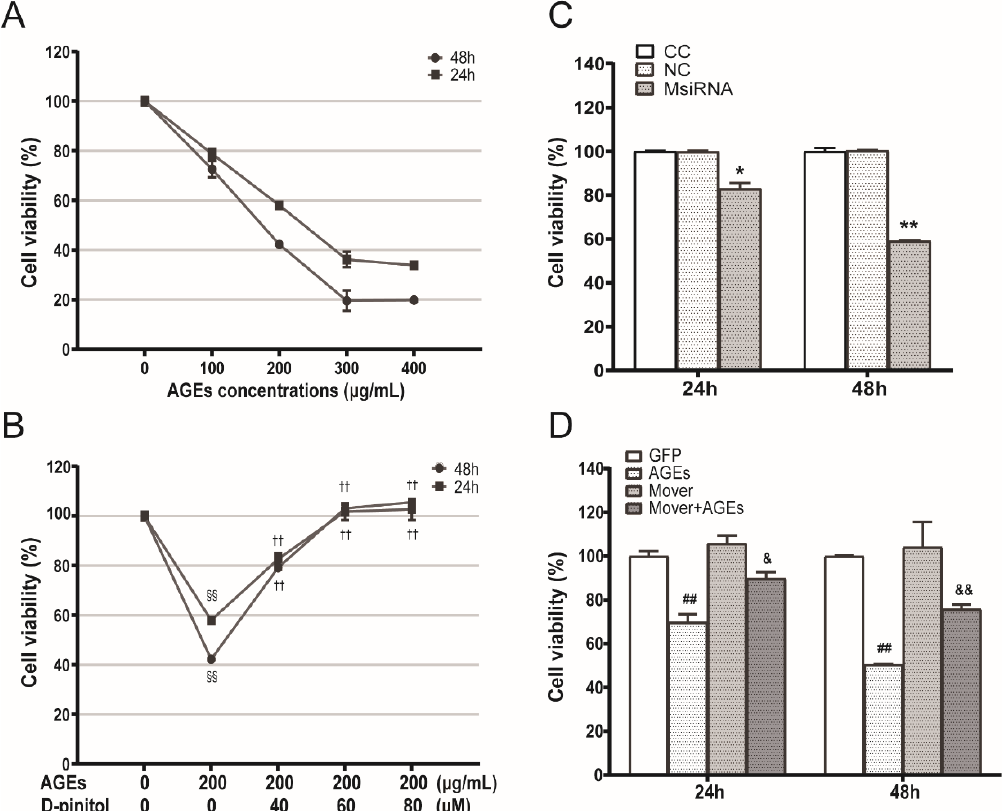
Figure 4. Role of MFG-E8 and D-pinitol on the cell viability of STC-1 treated with AGEs. ( A ) Effects of different concentrations of AGEs (0, 100, 200, 300, 400 µ g/mL) on viability in STC-1 at 24 h and 48 h with MTT. ( B ) Effects of D-pinitol on viability in STC-1 treated by AGEs at 24 h and 48 h with MTT. ( C ) Effects of MFG-E8 siRNA on viability in STC-1 at 24 h and 48 h. ( D ) Effects of MFG-E8 overexpression on viability in STC-1 treated by AGEs. Results were expressed as percent of untreated cells (100%) and are given as the means ± SD from six independent experi- ments. §§ p < 0.01 vs. CC group; †† p < 0.01 vs. CC + AGEs group; * p < 0.05, ** p < 0.01 vs. NC group; ## p < 0.01 vs. GFP group; & p < 0.05, && p < 0.01 vs. GFP+AGEs group. AGEs: advanced glycation end